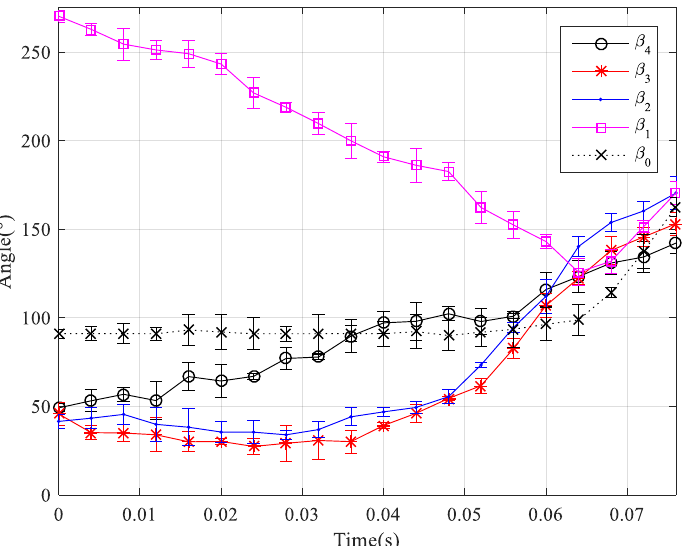
Figure 7. Angles of each joint of the flying squirrel’s hind limbs when jumping for gliding.